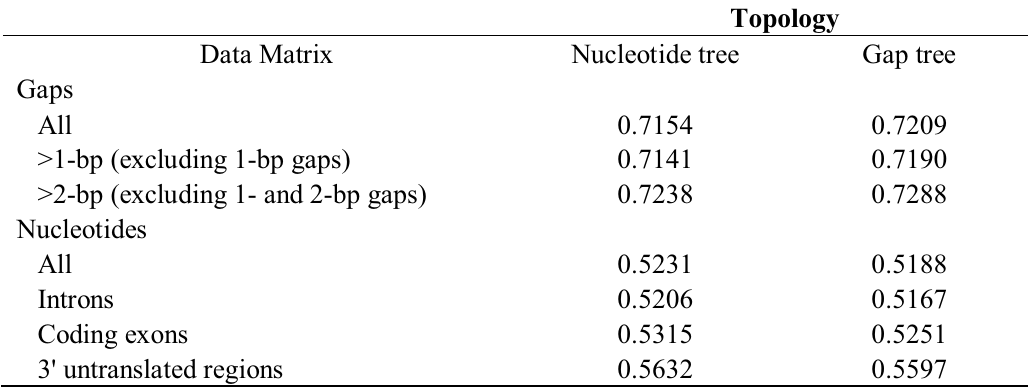
Table 2. Retention indices [88] for gap characters and nucleotide data. Retention